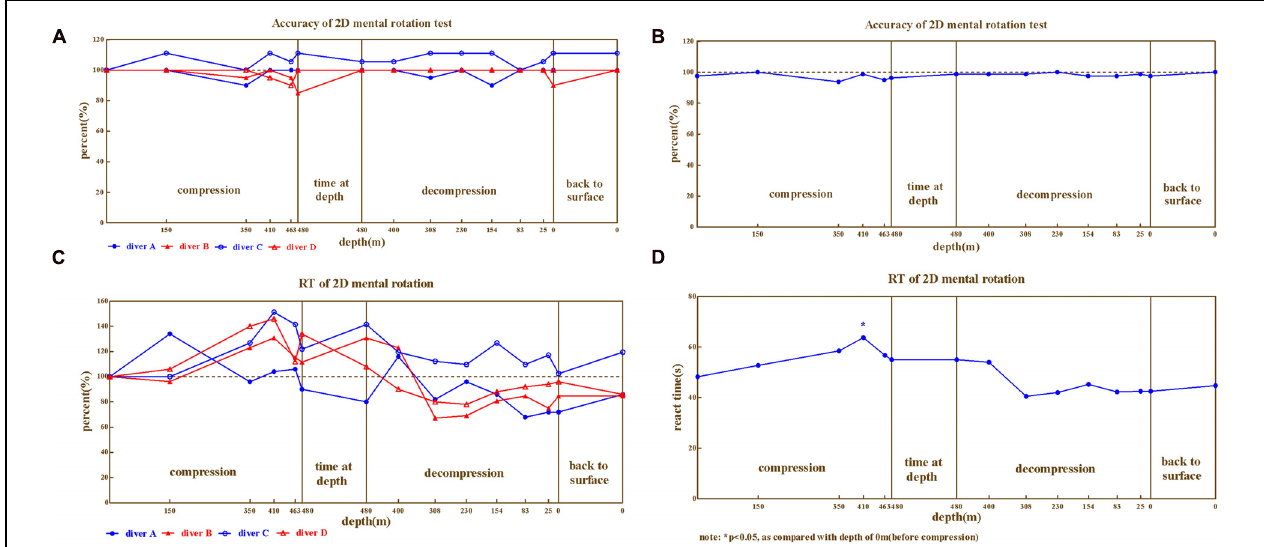
FIGURE 2 | The results from 2D mental rotation. (A) Correct rate for four divers, (B) Correct rate on Average, (C) Reaction time for four divers, (D) Reaction time on average.